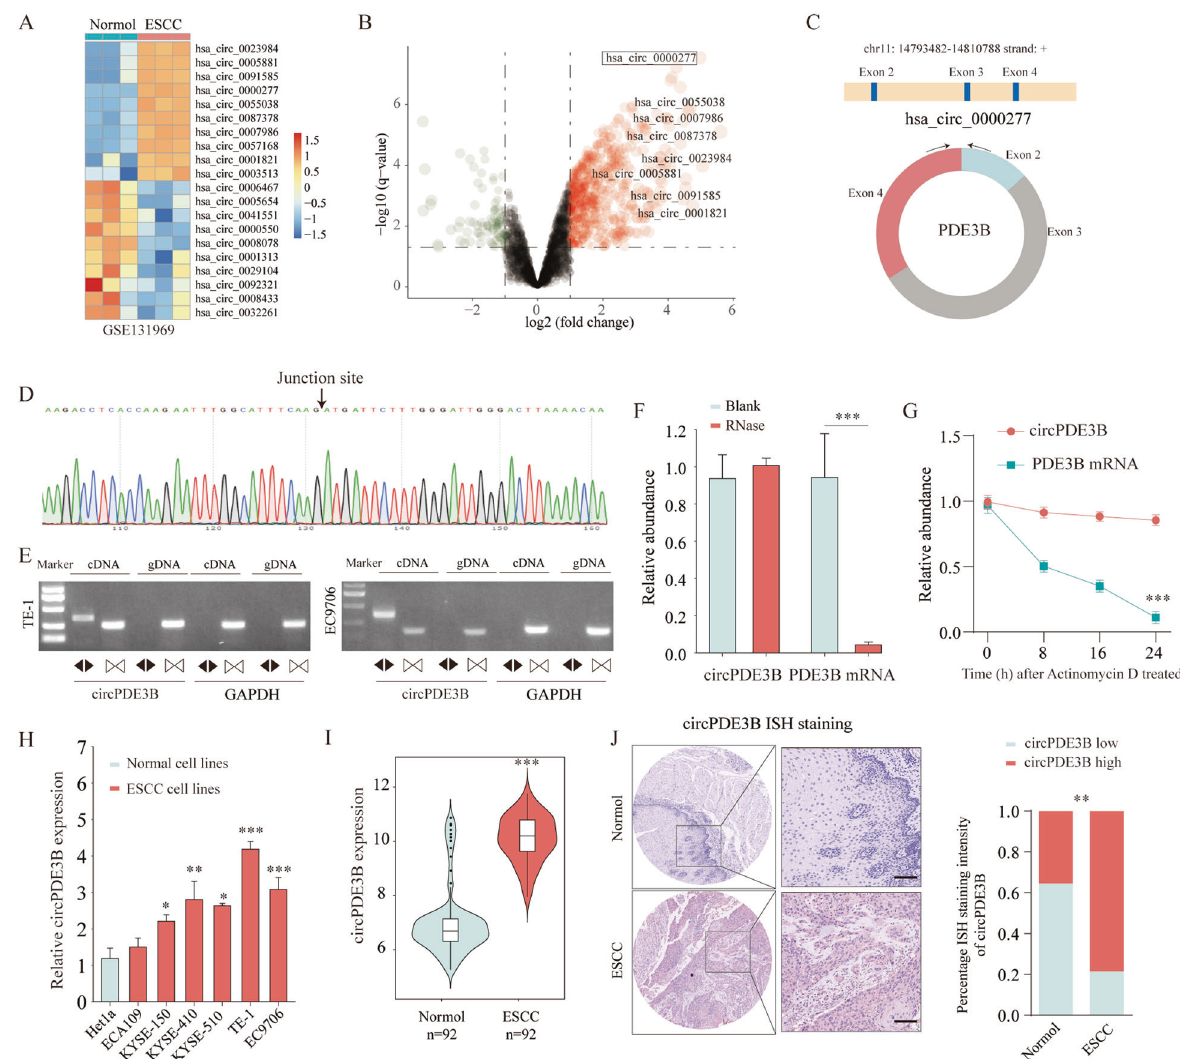
Fig. 1 Identi fi cation of differentially circular RNAs in ESCC. A Clustered heat map of the differentially expressed circRNAs in three pairs of human ESCC cancerous tissues and adjacent normal tissues (GSE131969). circRNAs with increased (yellow) or decreased (blue) expression are presented. B Volcano plots comparing the expression of circRNAs in ESCC cancerous tissues with adjacent normal tissues. The color indicated dots represent the circRNAs upregulated (red dots) and downregulated (green dots) by 1.5-fold and p values < 0.05. C The genomic loci of the PDE3B gene and circPDE3B. D The back-splice junction site of circPDE3B was validated by Sanger sequencing. E RT-PCR assay with divergent or convergent primers indicated the existence of circPDE3B in ESCC tissue. GAPDH was used as a negative control. F qRT-PCR analysis of PDE3B mRNA and circPDE3B after treatment with RNase R in EC9706 cells. G qRT-PCR analysis of PDE3B mRNA and circPDE3B in EC9706 cells after treatment with Actinomycin D. H Expression levels of circPDE3B in 92 paired ESCC specimens and the corresponding paired normal adjacent tissues. I Expression levels of circPDE3B determined by qRT-PCR in mammary normal cell lines and ESCC cell lines. J Representative images and analysis results of circPDE3B expression in ESCC tissues were detected by ISH assays. Scale bar, 200 μ m. * p < 0.05, ** p < 0.01, *** p < circPDE3B, in ESCC tissues as compared with the matched regulated EMT process. Therefore, it is believed that circRNAs can nonneoplastic counterparts (Fig. 1A, B; Supplementary Table S2). provide new insight into the molecular mechanisms of cancer Comparison of the PDE3B mRNA sequences with the expected metastatic progression, and might also identify new treatment circPDE3B sequences from circBase showed that circPDE3B was targets for patients with metastatic-stage ESCC. looped and comprised exons 2 – 4 of its parental gene (Fig. 1C). We used Sanger sequencing to con fi rm the head-to-tail splicing (Fig. 1D). We also designed convergent and divergent primers for RESULTS amplifying the linear and circRNA based on TE-1 and EC9706 cell circPDE3B expression was upregulated in ESCC tissues and cell complementary DNA (cDNA) and genomic DNA (gDNA) using real- lines time polymerase chain reaction (RT-PCR). circPDE3B could only be We analyzed three paired ESCC tissue samples to investigate the ampli fi ed in cDNA, but not in gDNA (Fig. 1E). We used RNase R to ESCC tissue circRNA expression pro fi le using a circRNA microarray con fi rm circPDE3B stability. The RNase R sharply decreased the from Gene Expression Omnibus (GSE131969). There was signi fi - levels of the linear forms of PDE3B , but did not digest circPDE3B cantly increased expression of hsa_circ_0000277, also termed